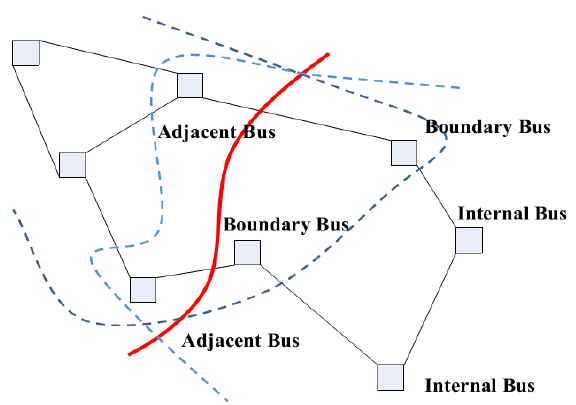
Figure 2. Decomposition of a power